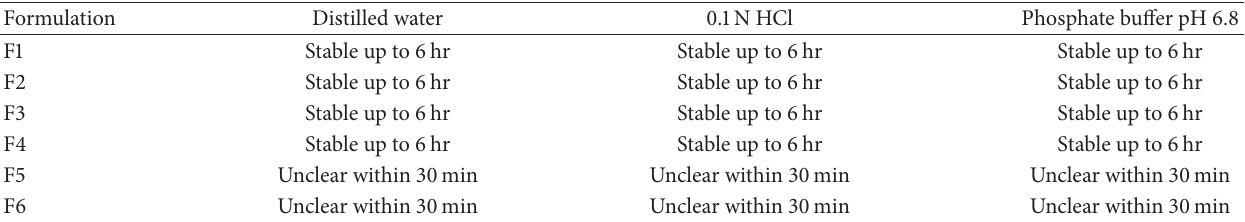
Table 3: Observation of dilution test.